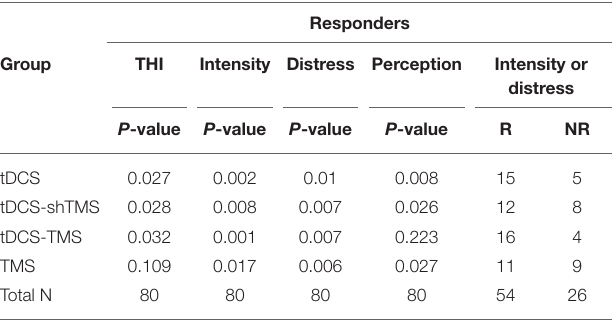
TABLE 2 | The responders with regard to either VAS intensity or